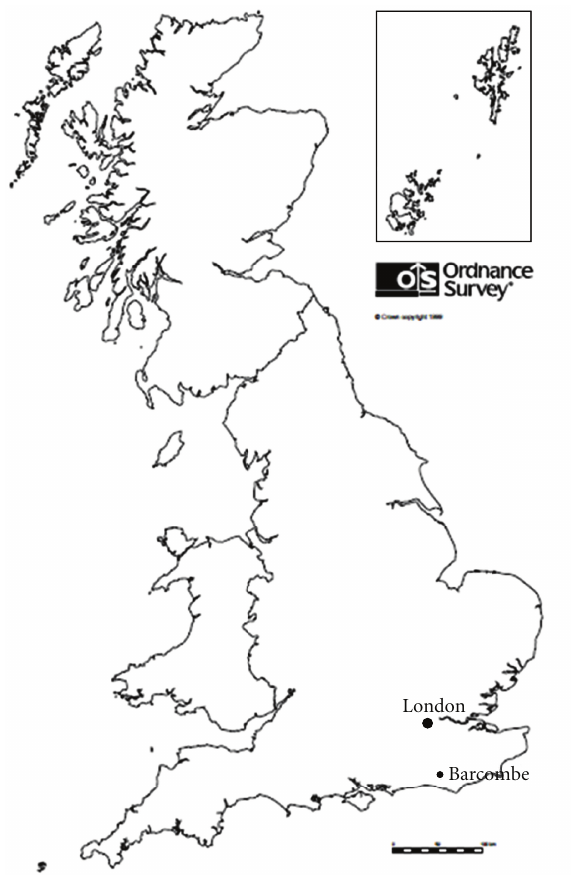
Figure 1: Location of the Barcombe Romano-British Villa.